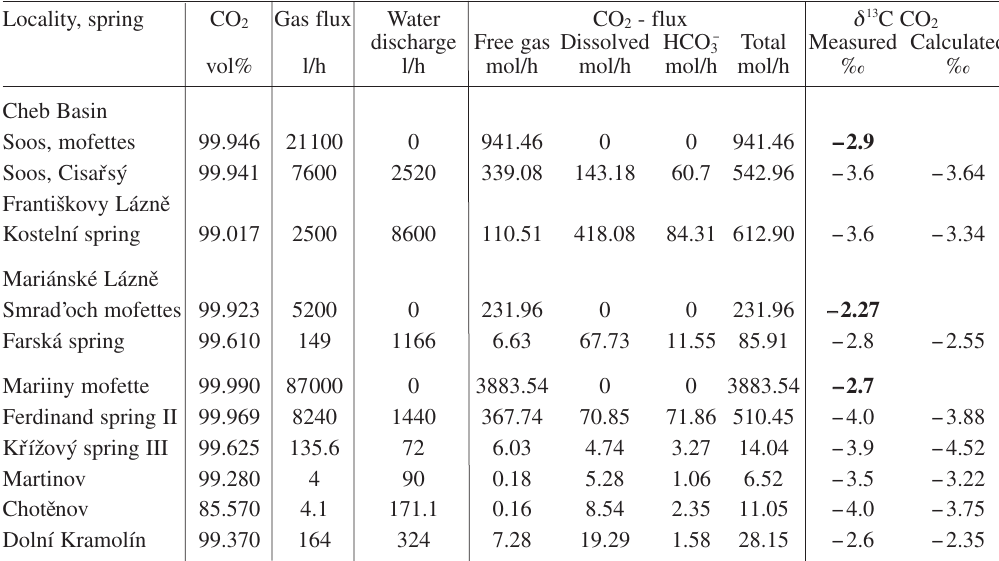
where m is the amount of CO 2 and ε the fraction- ation factors of –1.3 ‰ for ε diss-gas and 9.6 ‰ for ε HCO3-gas at 10°C (Wendt, 1968; Mook et al ., 1974; Zhang et al .,